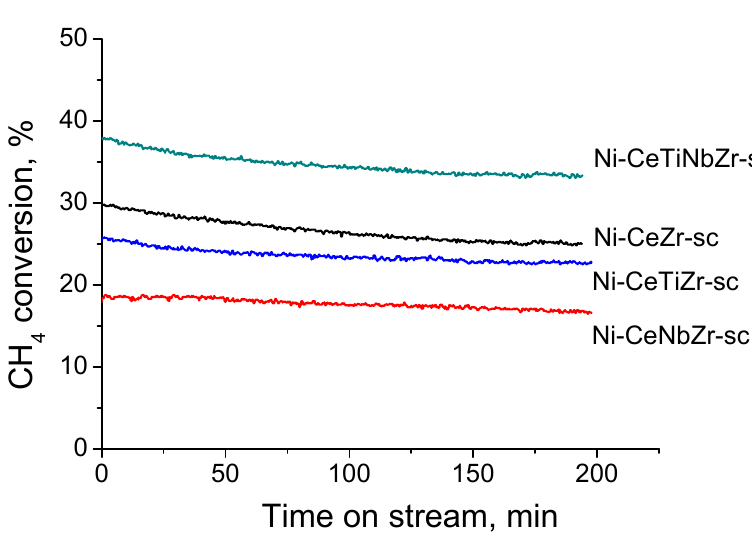
Figure 14. CH 4 conversion vs time on stream during MDR at T = 700 °C and contact time of 7.5 ms in the presence of different catalysts.